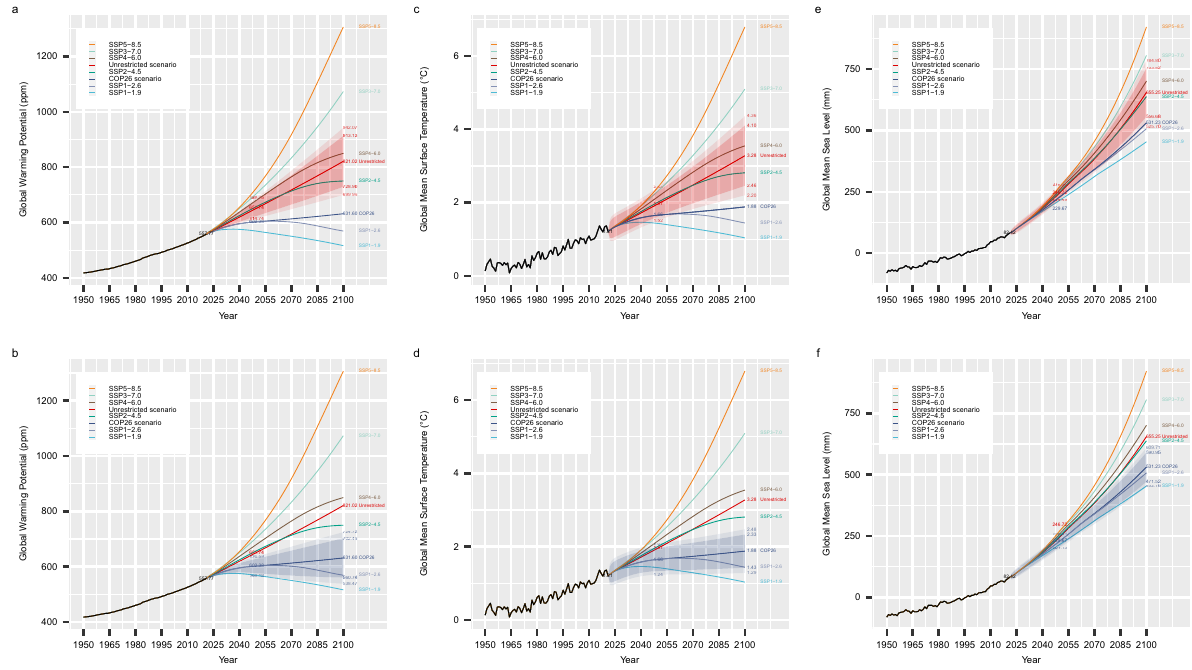
Figure 3. Data driven forecast of Global Warming Potential (GWP) ( a , b ), Global Mean Surface Temperature (GMST) ( c , d ), and Global Mean Sea Level (GMSL) ( e , f ) under the unrestricted scenario (red), the COP26 scenario (grey), SSP5-8.5 (orange), SSP3-7.0 (light-green), SSP4-6.0 (brown), SSP2-4.5 (dark-green), SSP1- 2.6 (light-grey) and SSP1-1.9 (light-blue) from now till 2100, the uncertainties (forecast interval) under the unrestricted and the COP26 scenarios were shown by the red and grey shaded area. For the unrestricted and the COP26 forecast, values of the expected means and the 95% and 99% forecast intervals are shown for 2050 and 2100 respectively. Historical data before 2022 are shown in black. The modeling and forecast of GWP was based on an estimated ARIMA(1,1,1) model using historical data for the unrestricted scenario and integrating the proposed restriction for the COP26 scenario (with greenhouse gas emitted by Arctic permafrost added). The estimation and forecast of GMST and GMSL are based on the confirmed uSEM model as shown in Fig.